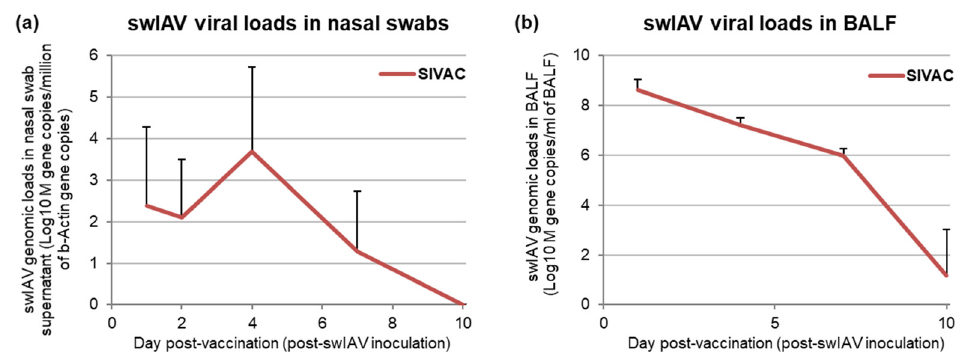
Figure 3. Swine influenza A virus (SwIAV) genomic loads quantified by M gene RT-qPCR ( a ) in nasal swab supernatants or ( b ) in bronchoalverolar lavage fluid (BALF) collected from piglets in the SIVAC group. Data are reported as the mean ( ± SD) of the group.